Question: Summarize what this figure shows in one sentence.
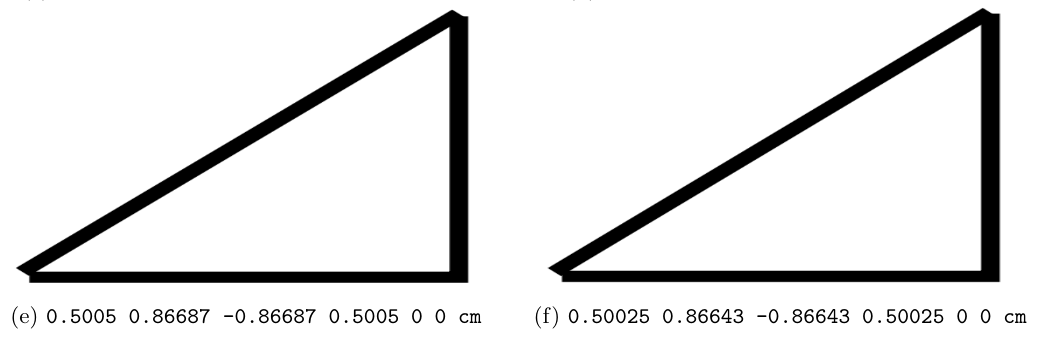
Answer: cm Operator - control, 1%, 0.5%, 0.2% 0.1%, 0.05% (0.1%)